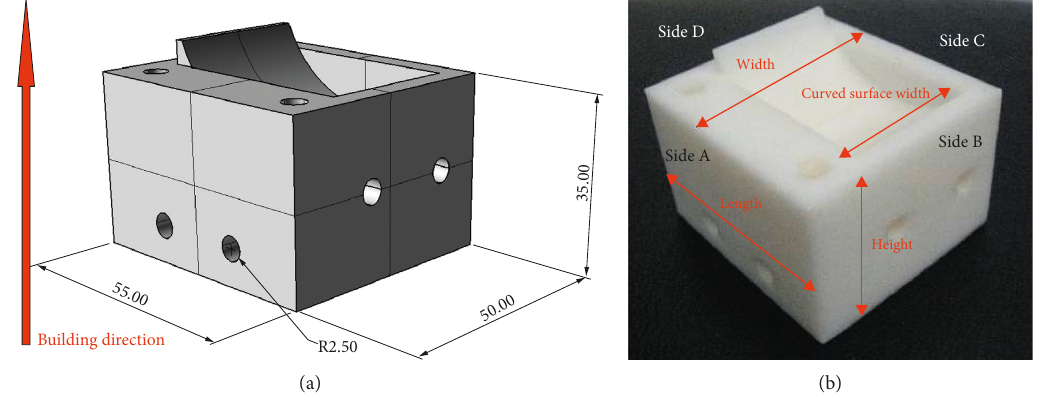
Figure 1: Geometrical design of the test piece (a) and measurements taken for the test pieces (b).